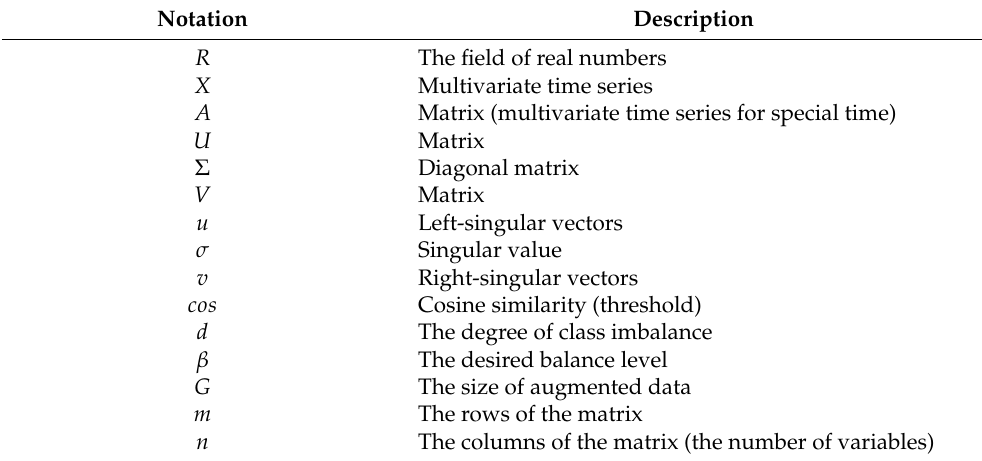
Table 1. The description of the